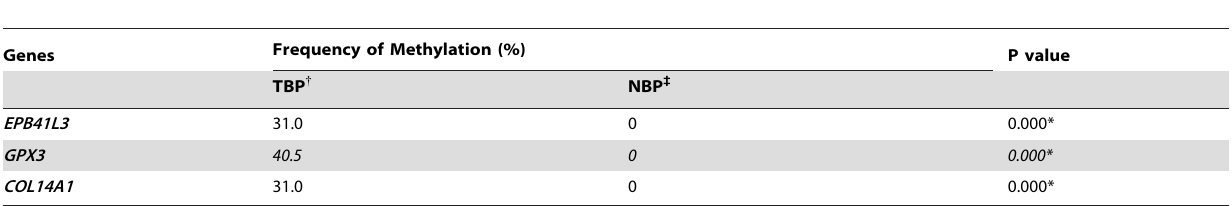
Table 5. Frequency of Promoter Methylation for Individual Genes in Blood Plasma of Esophageal Squamous Cell Carcinoma Patients and Controls.(n=